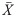
The boxplots of the CARLin values of the synthetic X¯ chart for different values of H when ARL0 = 370.4, m = 50 and n = 5.